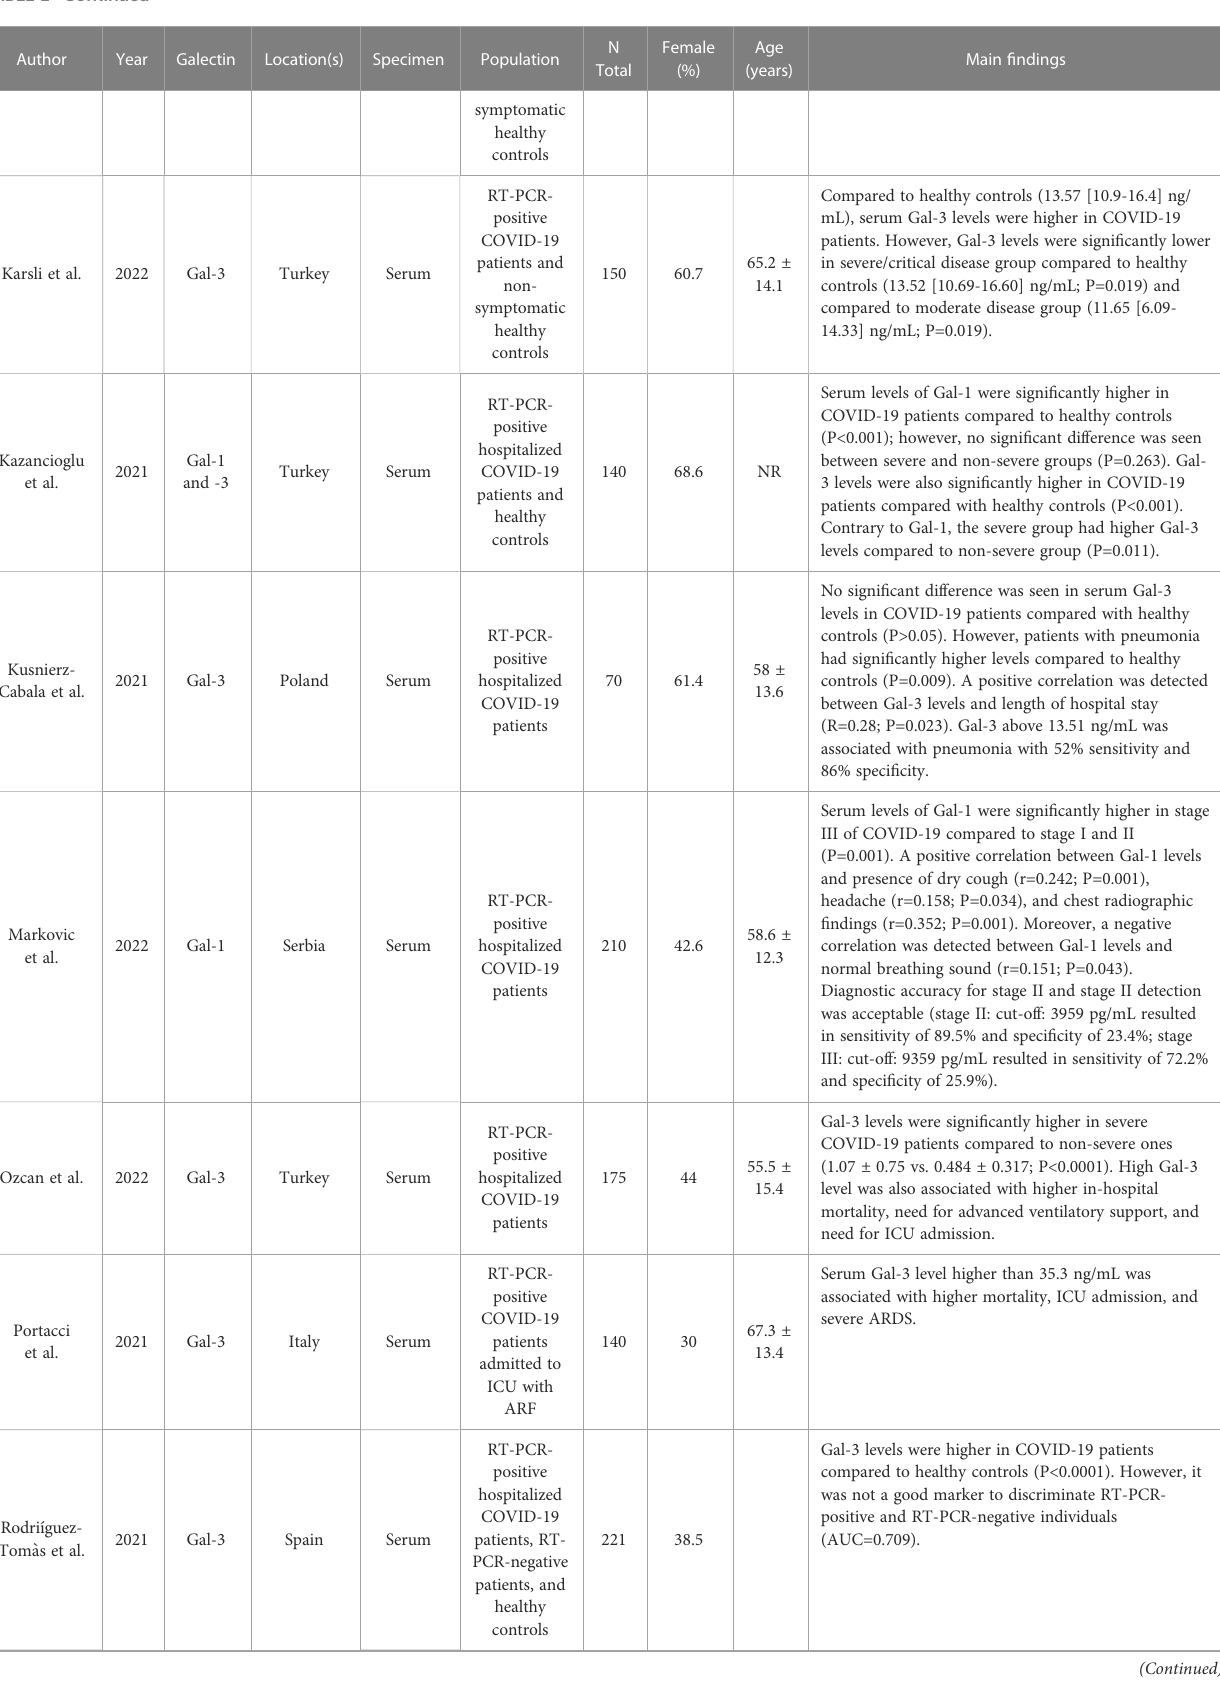
Gal-3 levels were higher in COVID-19 patients compared to healthy controls (P<0.0001). However, it was not a good marker to discriminate RT-PCR- positive and RT-PCR-negative individuals